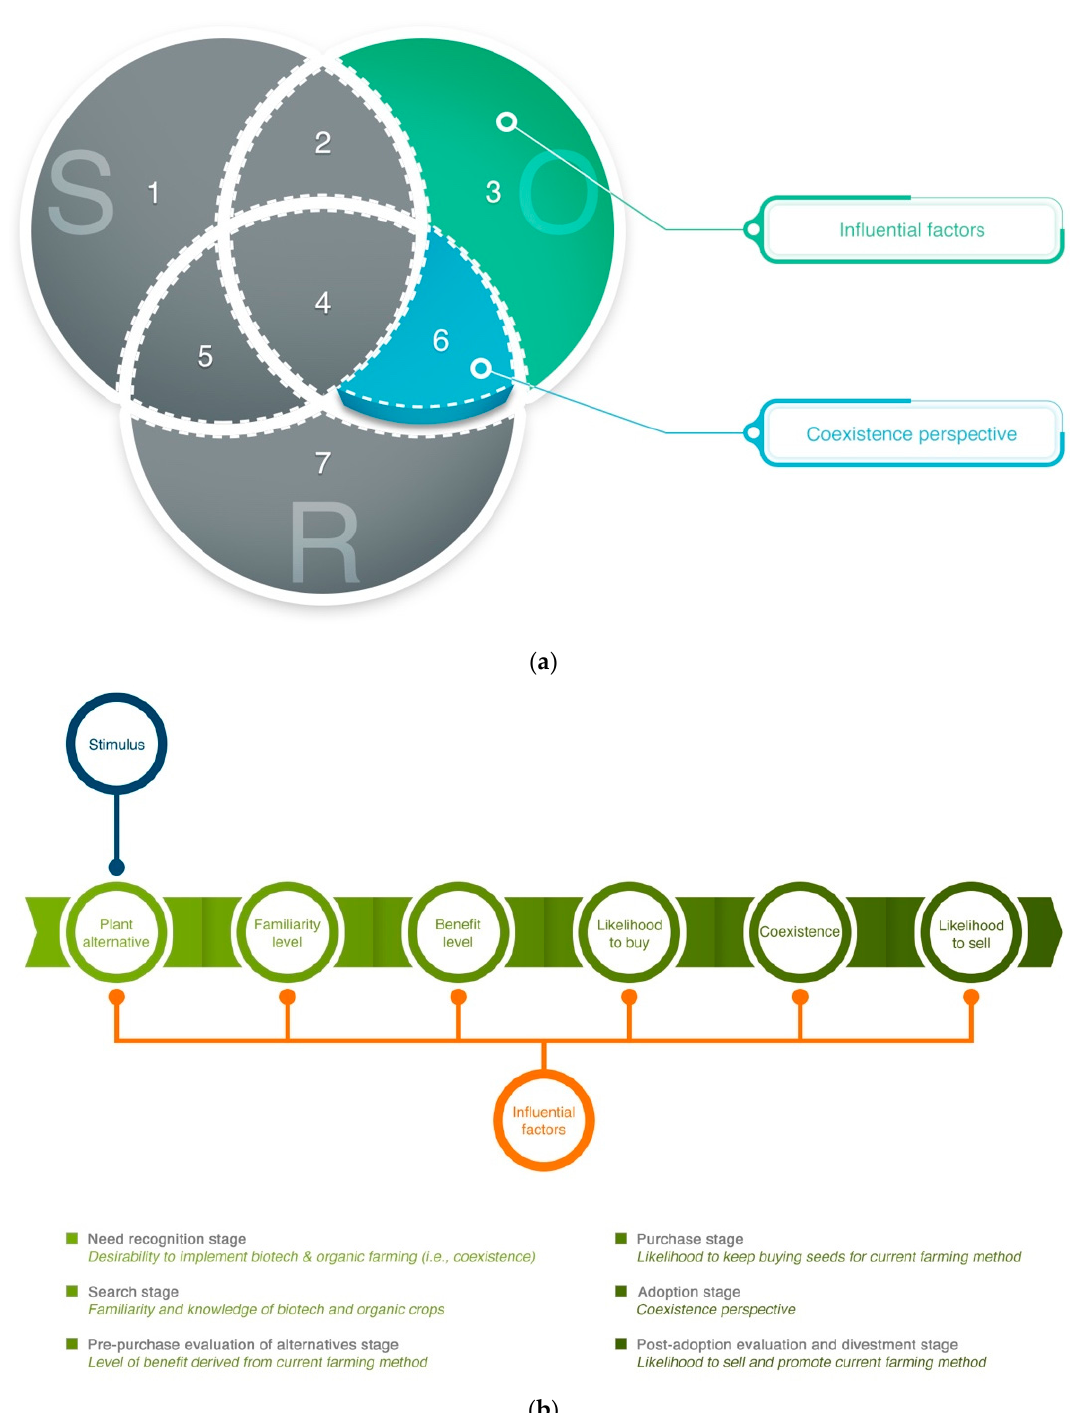
Figure 1. ( a , b ) Simplified Stimulus–Organism–Response Model ( a ) and Consumer Decision Model (CDM) ( b ), as contextualized in this study.